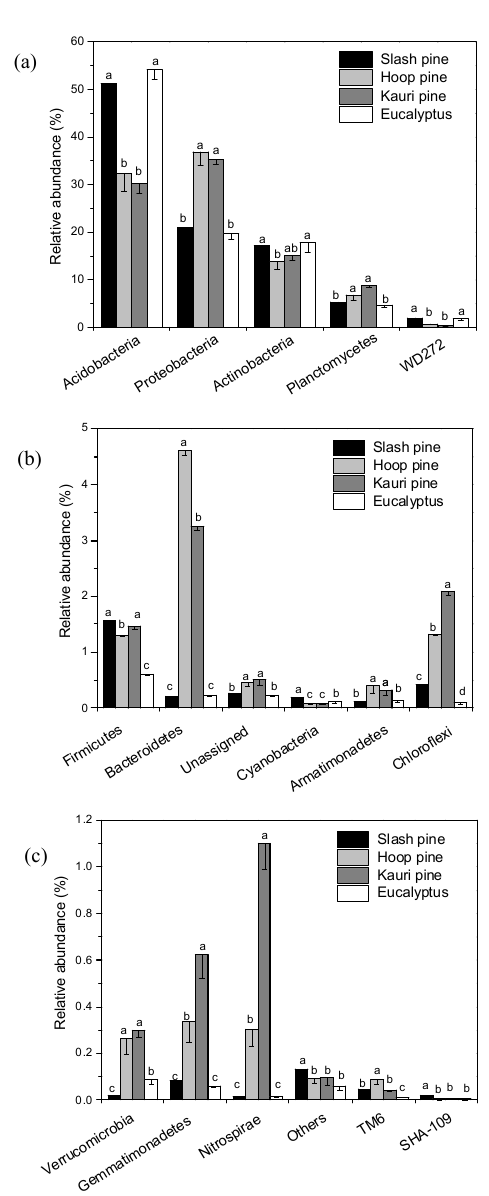
Figure 1. Most abundant bacterial phyla in soils under different tree species.